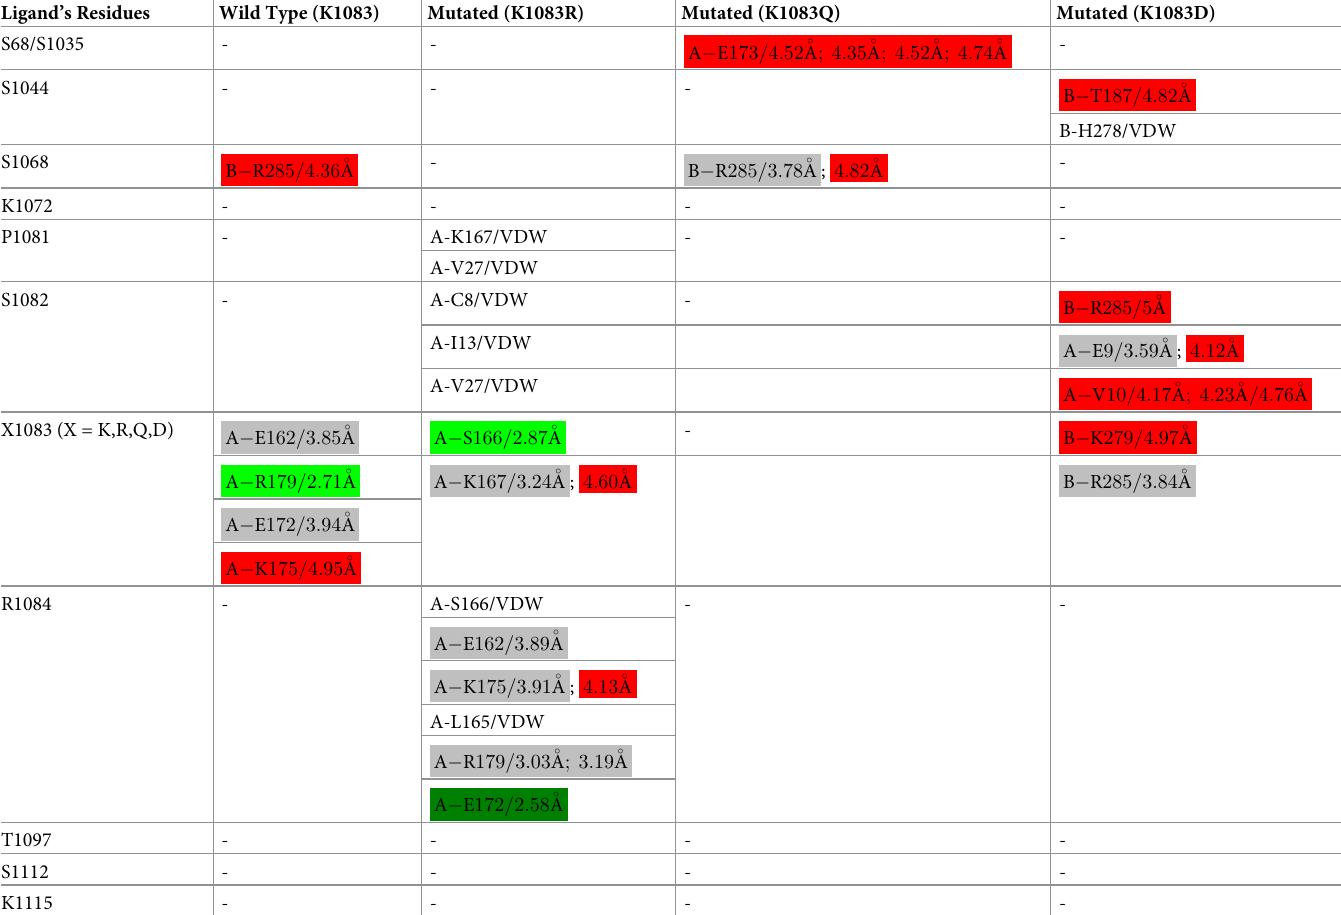
Table 3. Some important Interactions between receptor and ligand. Ligand’s